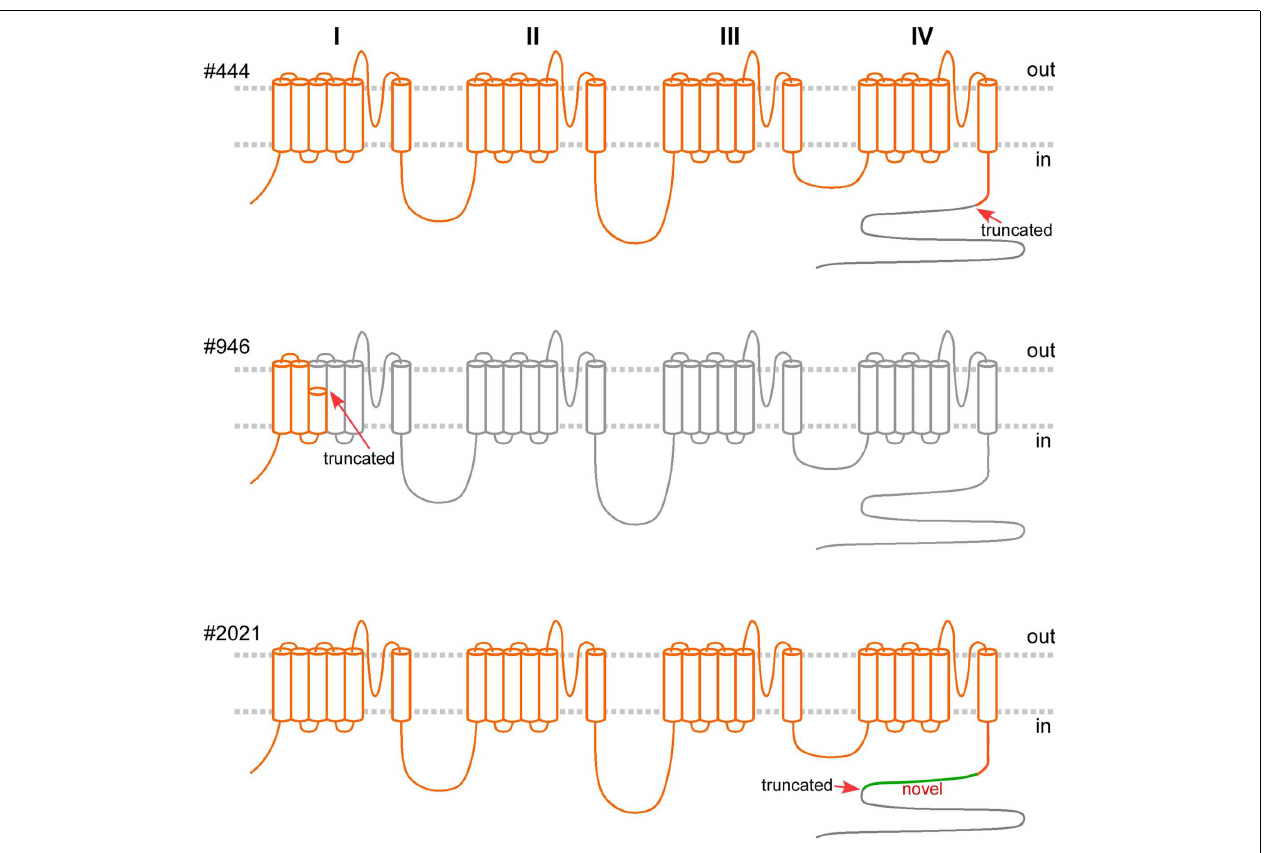
gene product of the mutated allele in Pt #946 encodes only the first three transmembrane segments.The gene product in Pt#2021 of the mutated allele with the deletion of exon 39–40, if translated, is predicted to comprise 79 novel residues (in green) following residue 1917, missing the tail